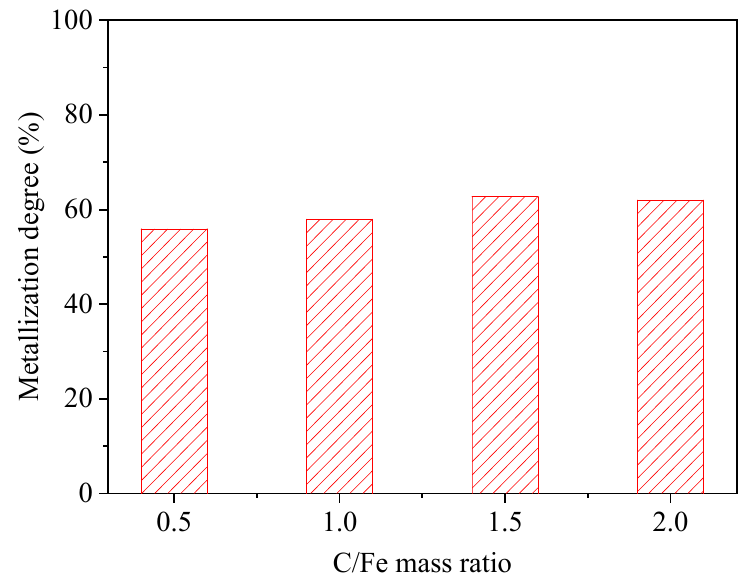
Figure 6. Effect of C/Fe mass ratio on metallization of reduced pellets of high-aluminum iron ore (HA ore) (reducing at 1050 °C for 90 min).